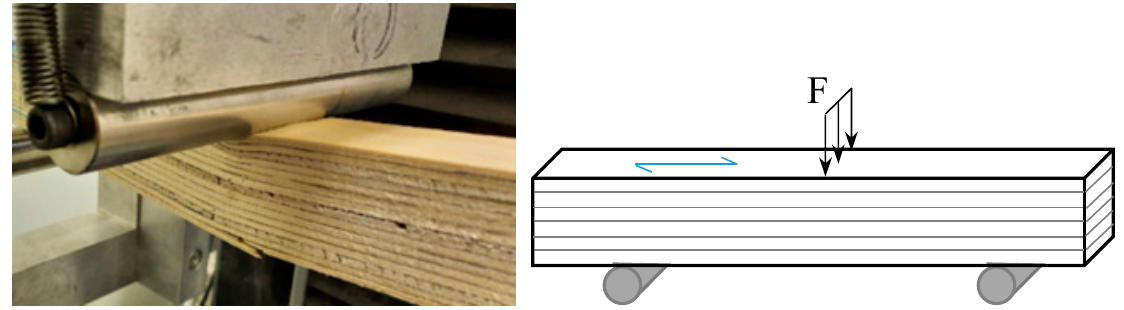
Figure 2. A determination of the bending strength of the specimens. The specimens were intended to determine changes in their bending properties after different levels of exposure were divided into four groups (Figure 3). Ten specimens were involved in each group. In order to investigate the effect of soaking on any potential change in bending strength, Group 2 samples were soaked in water at 20 ± 1 ◦ C for forty-eight hours. Group 3 samples were soaked under analogous conditions, and then dried at 23 ± 2 ◦ C, 60 ± 5% relative humidity to a consistent weight, i.e., when the result of two concurrent weight tests at 24 h intervals can be seen to differ by less than 1% of the weight of the sample, after which they were soaked for a second time for a period of 48 h. The specimens in these groups were subjected to the bending test as soon as they were removed from the water. Group 4 specimens were soaked once. The samples taken from the water were dried under conditions of temperature 23 ± 2 ◦ C, humidity 60 ± 5% until a stable weight. After being soaked, after drying to a stable mass, the specimens were broken according to the same test methodology. Then any change in the percentages of thickness, length, width, and water absorption (which refers to the water content as a percentage of the mass of the sample) was calculated. The water absorption w (%) was calculated following Equation (1):